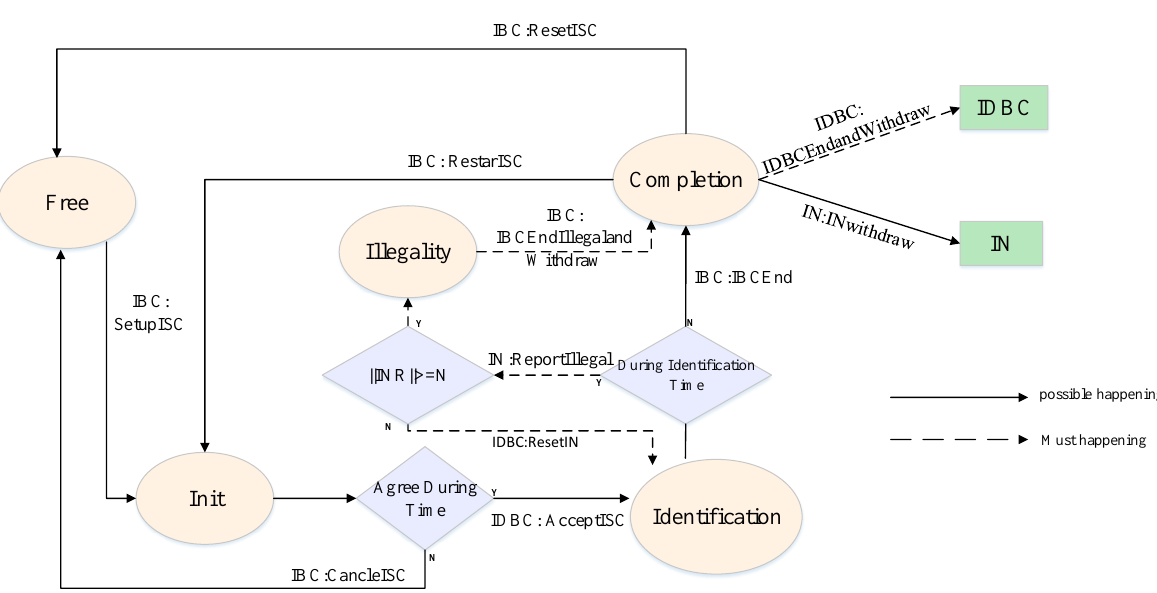
Figure 2. The transition of node states.